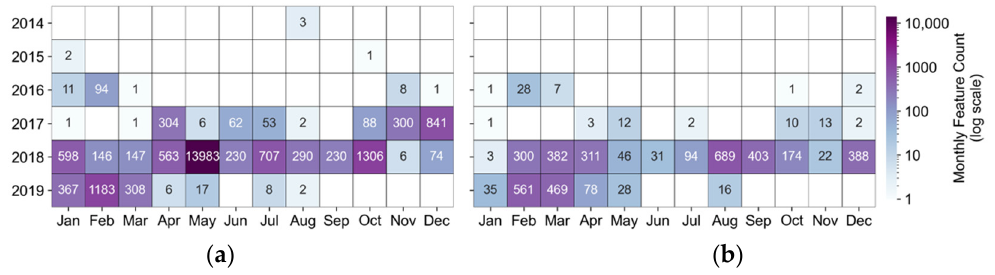
Figure 9. Monthly calendar heatmaps of ( a ) V1 (i.e., Version 1) creation dates and ( b ) Vn terminal version dates for SDG-relevant features in refugee settlements. Counts are presented on a logarithmic scale.